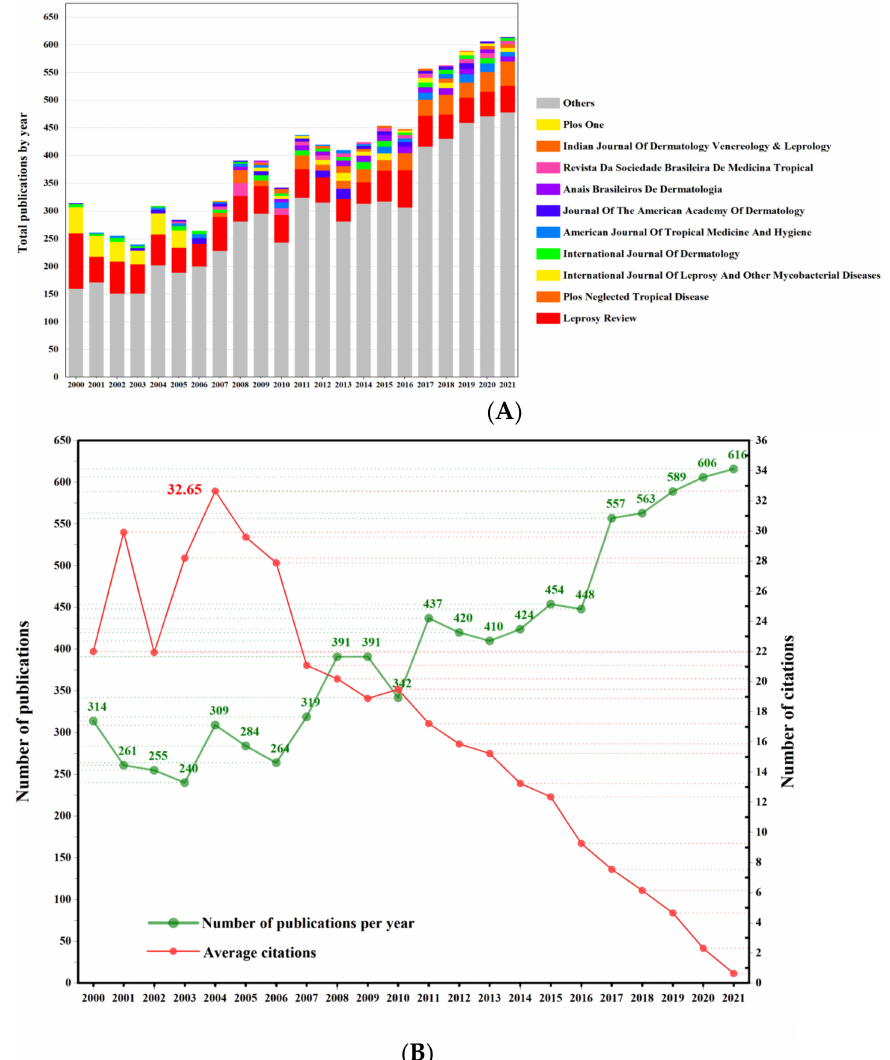
Figure 2. ( A ) Number of publications and citations in the field of leprosy (2000–2021). ( B ) The performance of the 10 most productive journals in all the publications